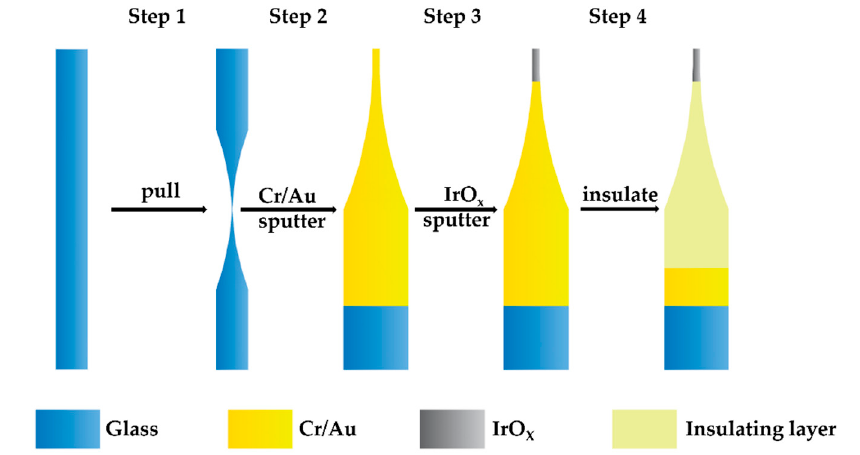
Figure 1. Process diagram showing the preparation of iridium oxide pH microelectrode based on sputter deposition method.